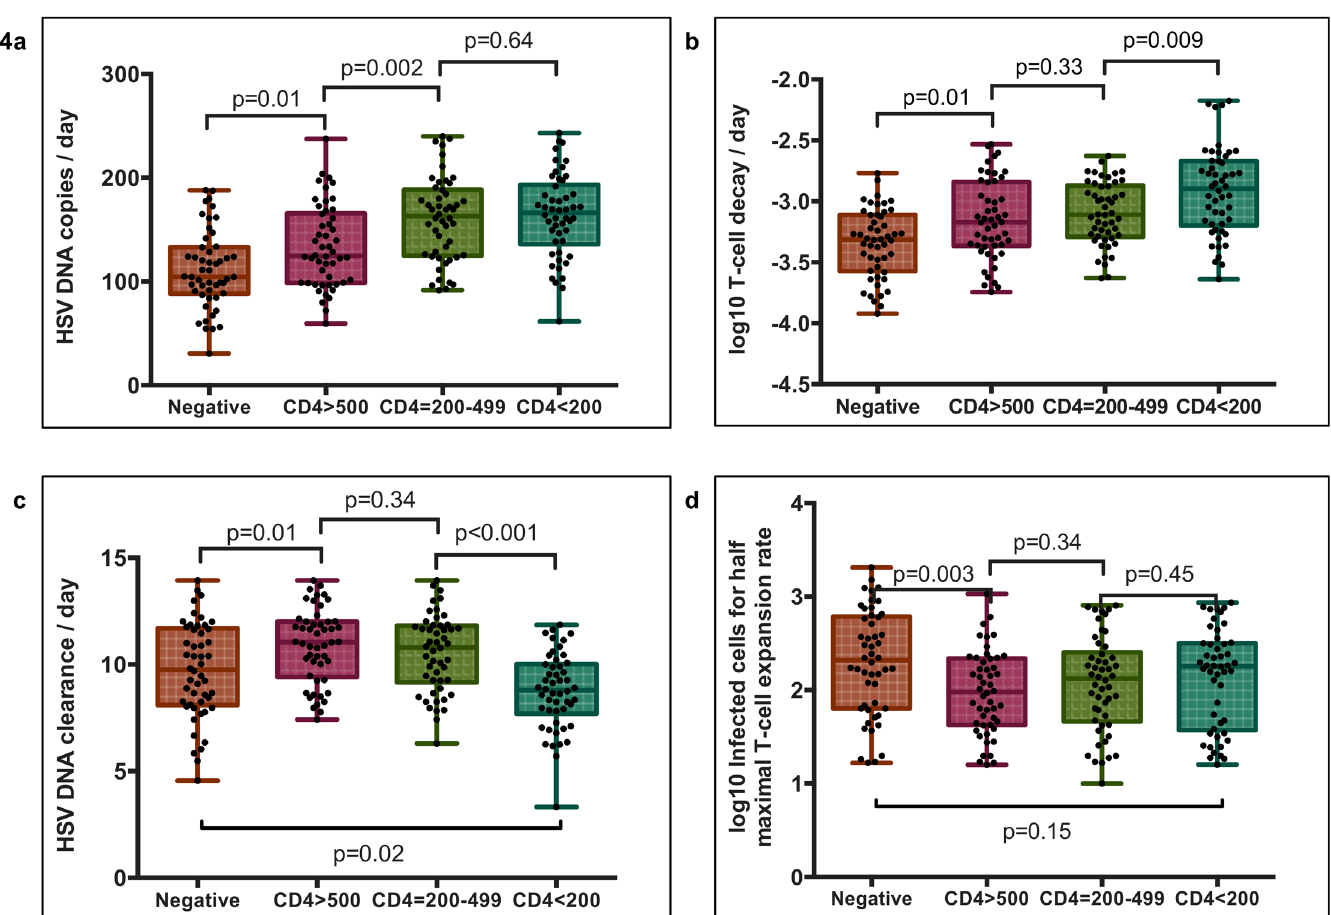
Fig 4. Immunologic determinants of increased HSV-2 shedding in HIV-1 infected men. Parameter sets represent the top 50 (5%) model fits for each group. Boxplots whiskers are inclusive of the full range of values. The box includes interquartile range and a median line. (A) HSV-2 release rate from ganglia to the genital tract, (B) Genital T-cell decay rate, (C) Genital HSV-2 DNA clearance rate and (D) Number of infected cells needed to stimulate half- maximal genital T-cell expansion. All comparisons are with Mann Whitney rank tests. Of note, genital T-cell levels in the model are intended as a surrogate measure of cytolytic immune